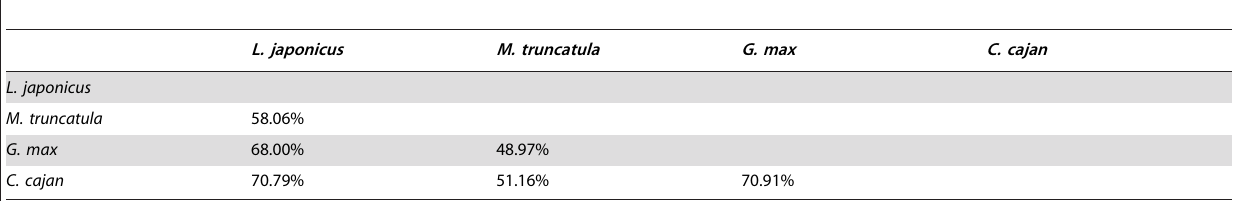
Table 3. The synteny quality of regions orthologous across L. japonicus , M. truncatula , G. max and C. cajan.